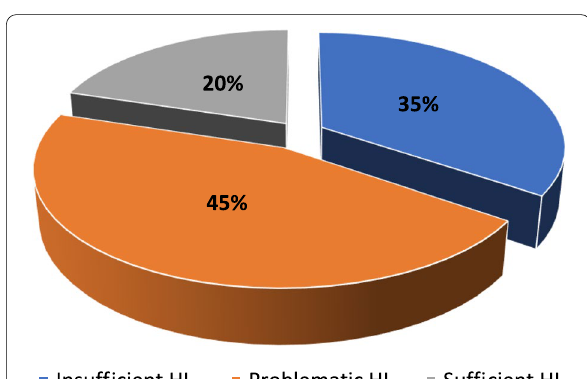
Fig. 2 Health literacy (HL) level of studied pregnant women attending antenatal care (ANC) clinics in Mansoura